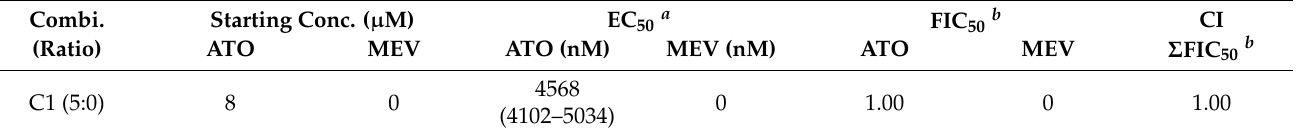
Table 1. Half-maximal inhibitory concentrations of the atorvastatin and mevastatin combinations.